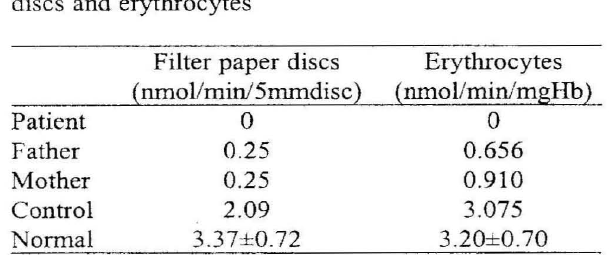
Table 3. DHPR activity in dried blood on filter paper